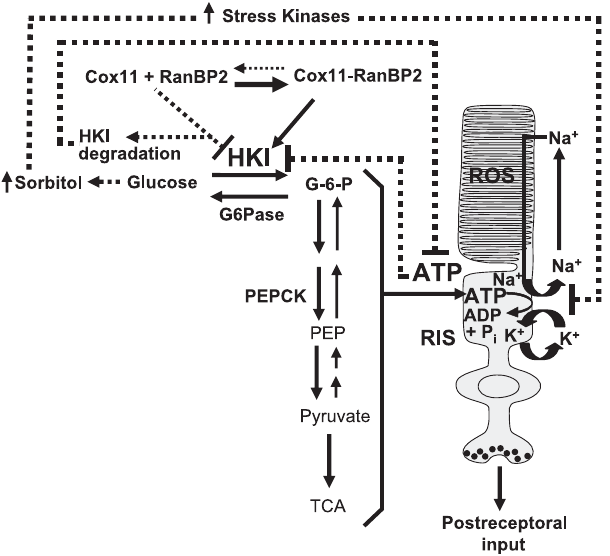
Figure 9. Model Depicting a Role of RanBP2 and Some of Its Partners in Metabolic and Neuronal Function RanBP2 interacts with Cox11 and HKI and the triad is in equilibrium under normal physiological conditions. RanBP2 prevents the inhibition of HKI by Cox11 and its degradation. The ultimate effect of RanBP2 on its partners is the stimulation of the glycolytic pathway and production of ATP. The glycolytic pathway is critical to fuel the constitutive Na þ /K þ - ATPase pump to maintain the dark current between the inner and outer segment compartments of photosensory neurons. A deficit (haploinsuf- ficiency) in RanBP2 disturbs the equilibrium between RanBP2, HKI, and Cox11. This pathophysiological event promotes the destabilization and degradation of HKI and a decrease in ATP production required to maintain the depolarization state neurons, and, hence, a reduction in the response of receptoral and postreceptoral neurons. A reduction in ATP levels also negatively modulates HKI activity/level. Decreased levels of HKI promote intracellular hyperglycemia and activate stress kinases, which modulate negatively the Na þ /K þ -ATPase pump by phosphoryla- tion. Pathophysiological pathways promoted by RanBP2 haploinsuffi- ciency are represented by dash lines. RIS, rod inner segment; ROS, rod outer